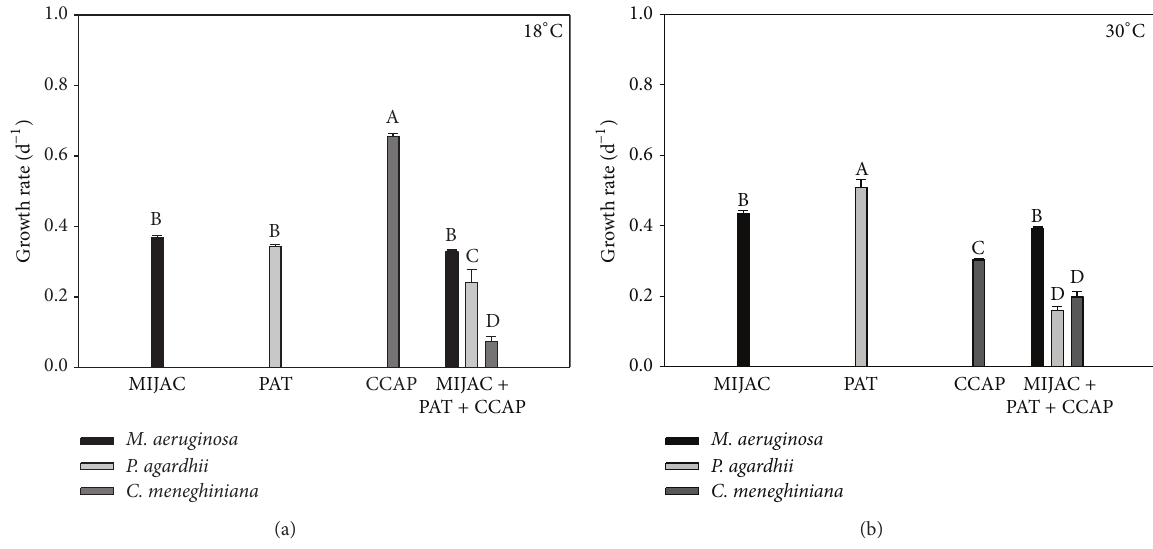
Figure 6: Chlorophyll- a -based growth rate of monocultures and mixed cultures of M. aeruginosa (MIJAC), P. agardhii (PAT), and C. meneghiniana (CCAP) at two different temperatures (18 ∘ C and 30 ∘ C). Different letters represent significant differences at 𝑝 < 0.05 .